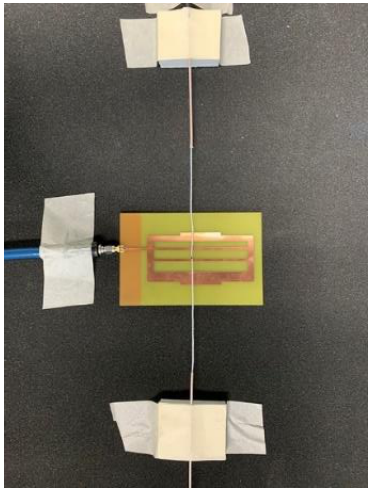
Figure 13. Actual measurement picture.